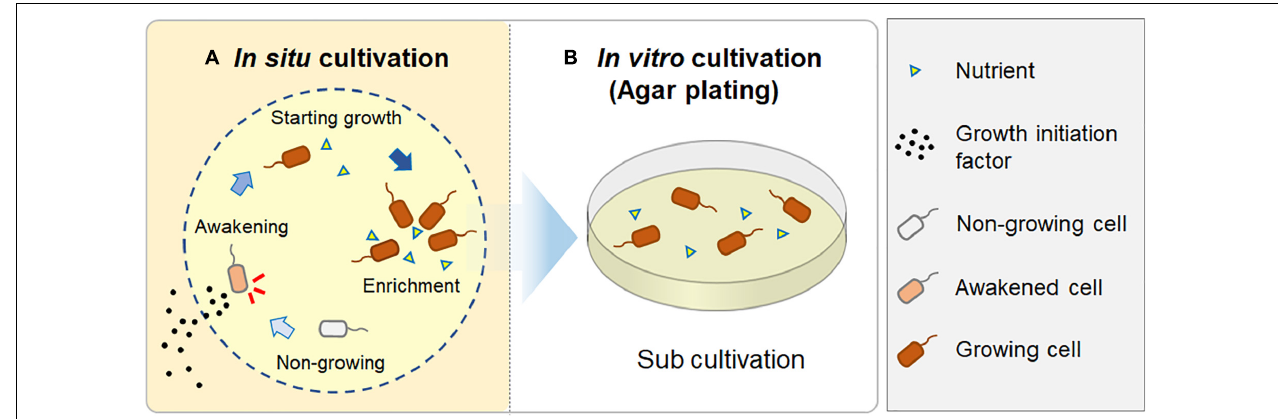
FIGURE 6 | A hypothesis for how in situ cultivation yields different isolates from microbial recovery in a natural environment. During in situ cultivation, dormant microbes are induced from a non-growing state by growth initiation factor from the outside environment. They then start to grow and become enriched, supported by sufficient nutrients in the chamber (A) ; when they are sub-cultured after the in situ cultivation, they continuously grow on an agar plate, resulting in visible colony appearance (B)